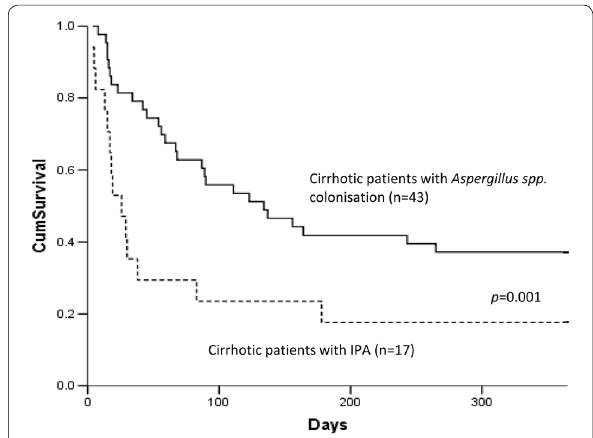
Fig. 2 Kaplan–Meier survival curve of 17 cirrhotic patients with IPA and 43 patients with Aspergillus spp. colonisation. Curves were compared using log‑rank